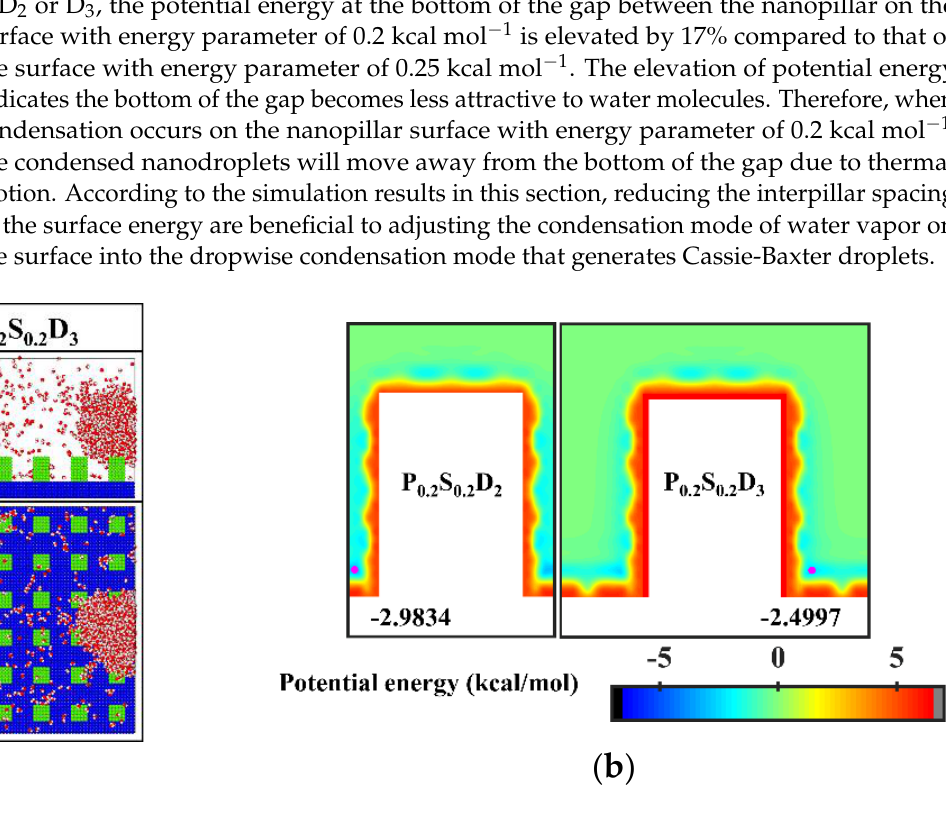
Figure 6. ( a ) The snapshot of the condensate formed on the surfaces at the end of the simulation in the cases of P 0.2 S 0.2 D 2 and P 0.2 S 0.2 D 3 . ( b ) Equipotential curves of potential energy between water mol- ecule and the nanopillar surfaces (P 0.2 S 0.2 D 2 and P 0.2 S 0.2 D 3 ). The minimum values of the potential en- ergy are given in the figure and their positions are marked with a pink dot.